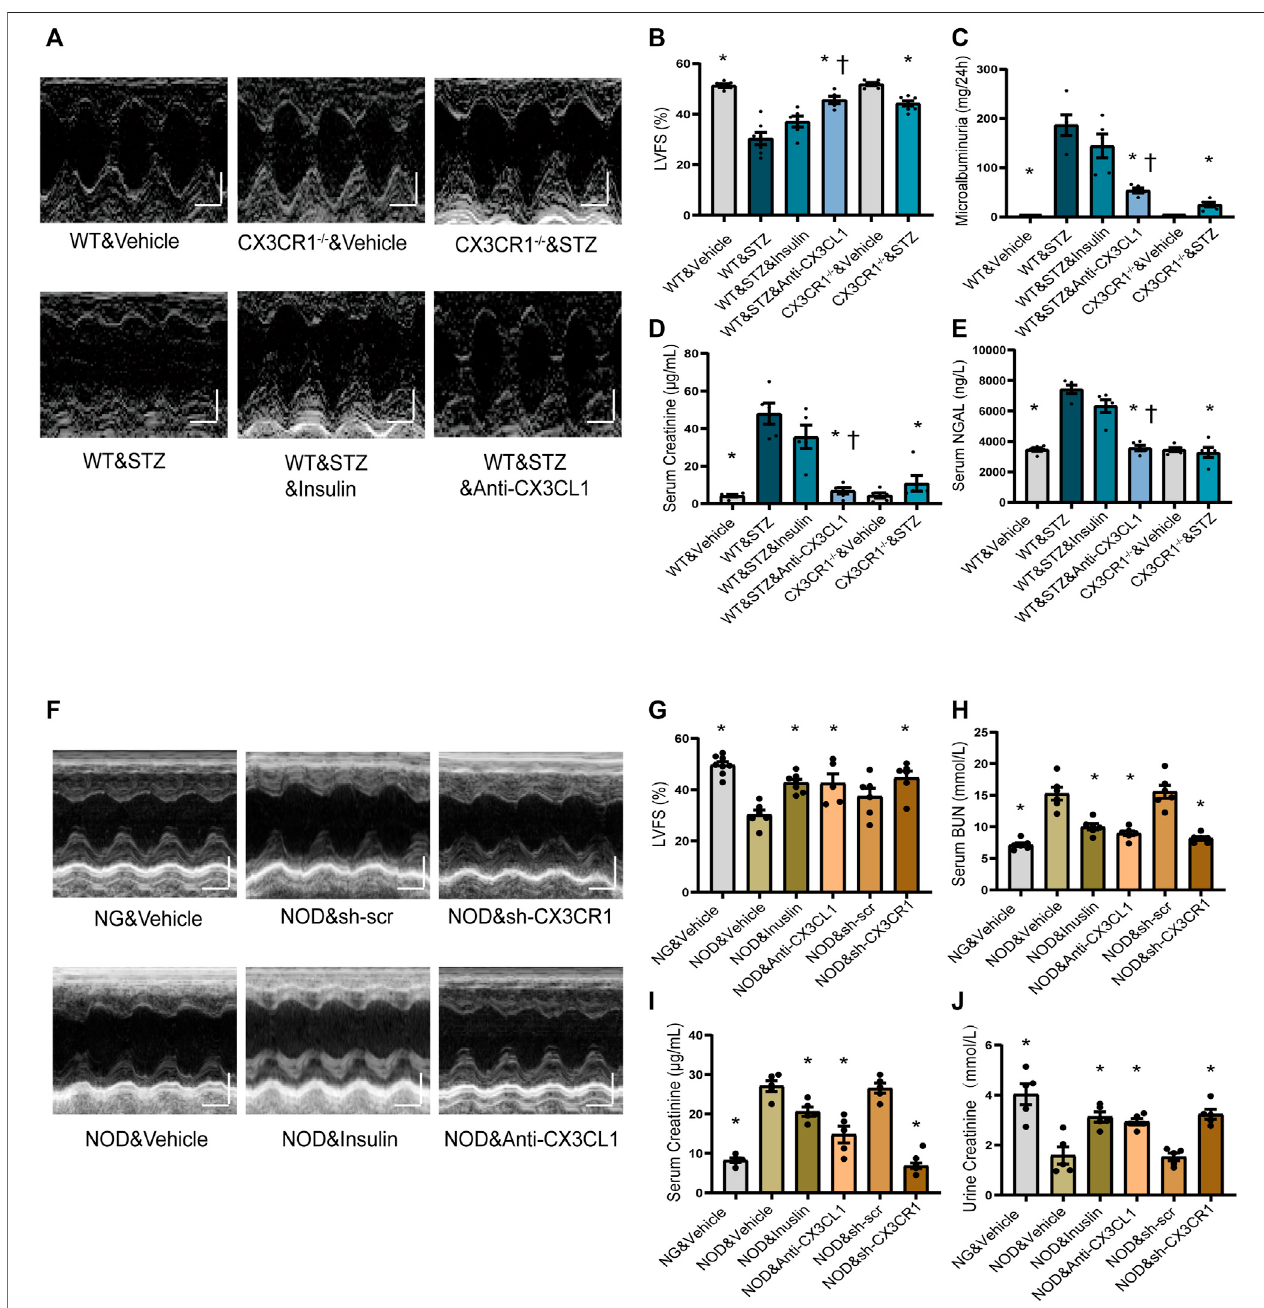
FIGURE 4 | Effect of CX3CL1/CX3CR1 inhibition on cardiorenal dysfunction in mice with diabetes-induced CRS. (A) Representative M-mode echocardiographic images of mice at 6 weeks after STZ injection. Scale bars, 2 mm (upper panels), horizontal bars represent 100 ms. (B) Left ventricular fractional shortening (LVFS). (C) Microalbuminuria amount for 24 h. (D) Serum creatinine levels. (E) Serum NGAL levels. For panels (B – E) , * p < 0.05 vs . WT&STZ group; † p < 0.05 vs . WT&STZ&Insulin group. For panel (B) , n = 6 in WT&Vehicle, WT&STZ&Inuslin, and CX3CR1 − / − &Vehicle group; n = 7 in WT&STZ and CX3CR1 − / − &STZ group; n = 5 in WT&STZ&anti-CX3CL1 group. n = 5 per group in panels (C – E) . (F) Representative M-mode echocardiographic images. Scale bars, 2 mm (upper panels), horizontal bars represent 100 ms. (G) LVFS. (H) Concentrations of serum BUN (urea nitrogen). (I) Serum creatinine levels. (J) Urine creatinine levels. For panel (G – J) , * p < 0.05 vs . NOD&Vehicle group. In panel (G) , n = 8 in NG&Vehicle; n = 6 in NOD&Vehicle, NOD&sh-scr, and NOD&sh-CX3CR1 group; n = 7 in NOD&Inuslin; n = 5 in NOD&Anti-CX3CL1. n = 6 per group in panel (H) ; n = 5 per group in panels (I – J) . Experiments presented in panels (B – E) and (G – J) were analyzed using one-way ANOVA followed by Bonferroni ’ s post hoc test.